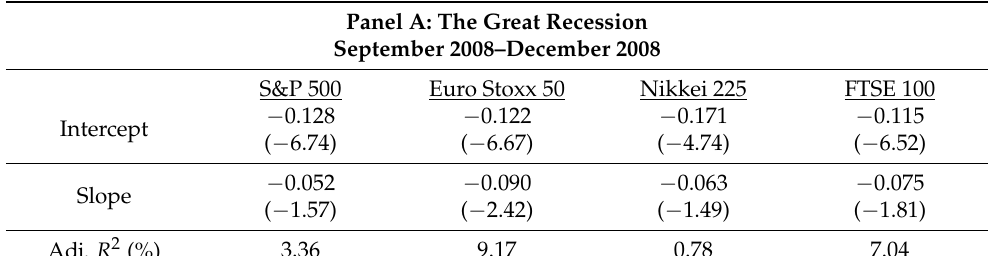
Table 8. Conditional Average Slopes of the Term Structure of the Expected Market Risk Premia. Panel A: The Great